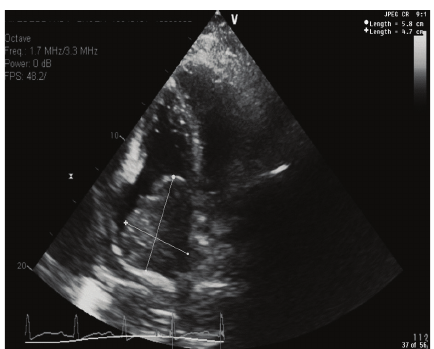
Figure 1: CT scan of the chest with contrast reveals a large lobulated anterior mediastinal solid mass (black arrow) with extension into the right hemithorax and the right atrium. There is displacement of the great vessels into the left hemithorax with significant mass effect on the right upper lobe. The tumor causes compression of the right pulmonary artery (red arrow) and right and left mainstem bronchi (white arrows).